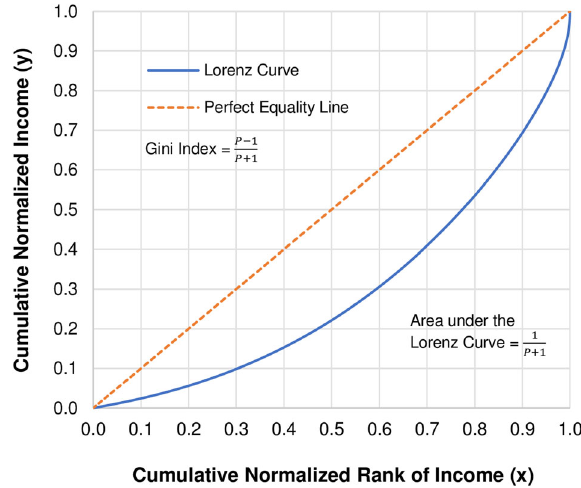
Fig. 1 The Lorenz curve. Given the speci fi ed functional form that is constructed based on the weighted average of the exponential function and the functional form implied by Pareto distribution, the closed-form expression for the Gini index can be conveniently computed as P (cid:1) 1 P þ